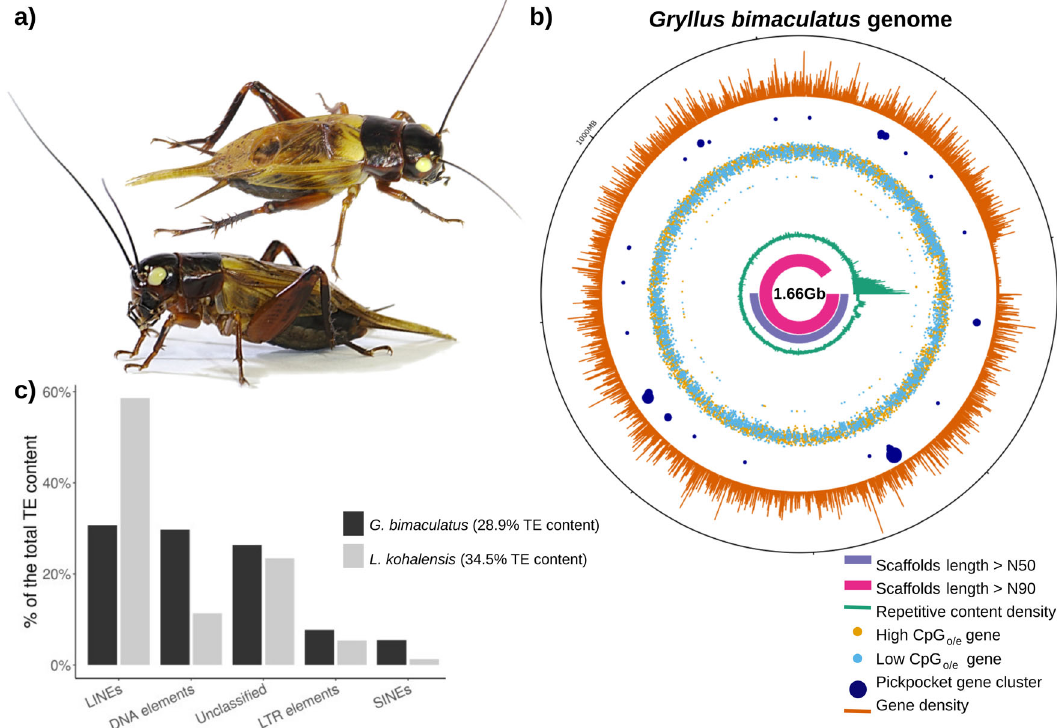
Fig. 1 The G. bimaculatus genome. a The cricket G. bimaculatus (top and side views of an adult male), commonly called the two-spotted cricket, owes its name to the two yellow spots on the base of the forewings. b Circular representation of the G. bimaculatus genome, displaying the N50 (pink) and N90 (purple) scaffolds, repetitive content density (green), the high- (yellow) and low- (light blue) CpG o/e value genes, pickpocket gene clusters (dark blue), and gene density (orange). c The proportion of the genome made up of transposable elements (TEs) is similar between G. bimaculatus and L. kohalensis (28.9 and 34.5%, respectively), but the speci fi c TE family composition varies widely between the two